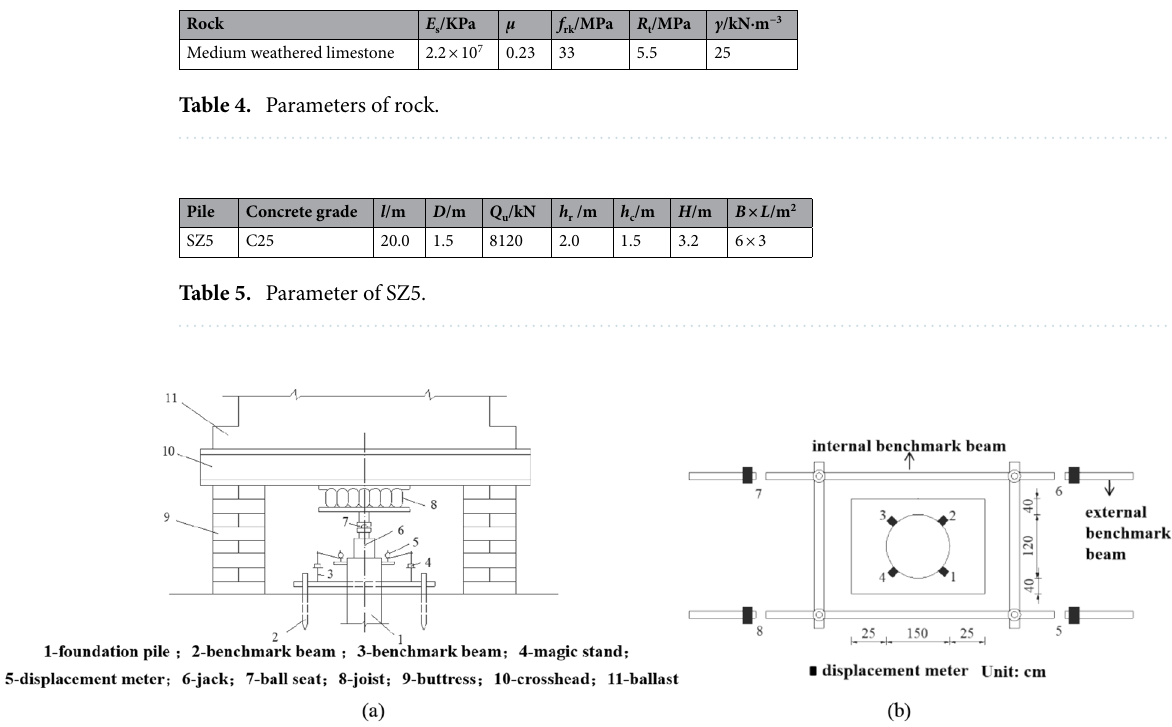
Figure 2. Test Equipment: ( a ) pile test platform and reaction device; ( b ) base beam